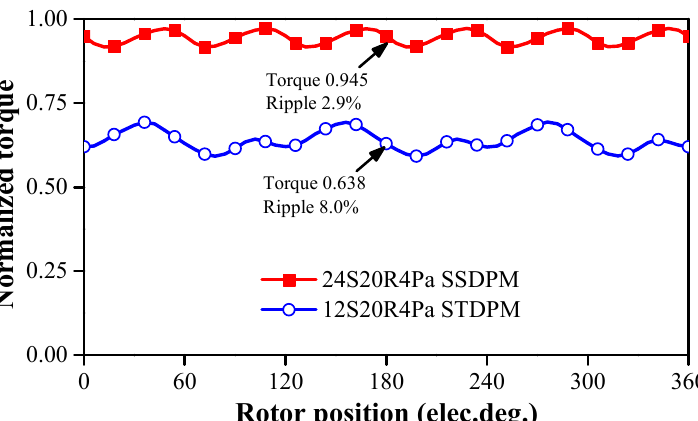
Figure 18. Comparison of torque waveforms of two dual-PM machines under the same copper loss (120 °C).